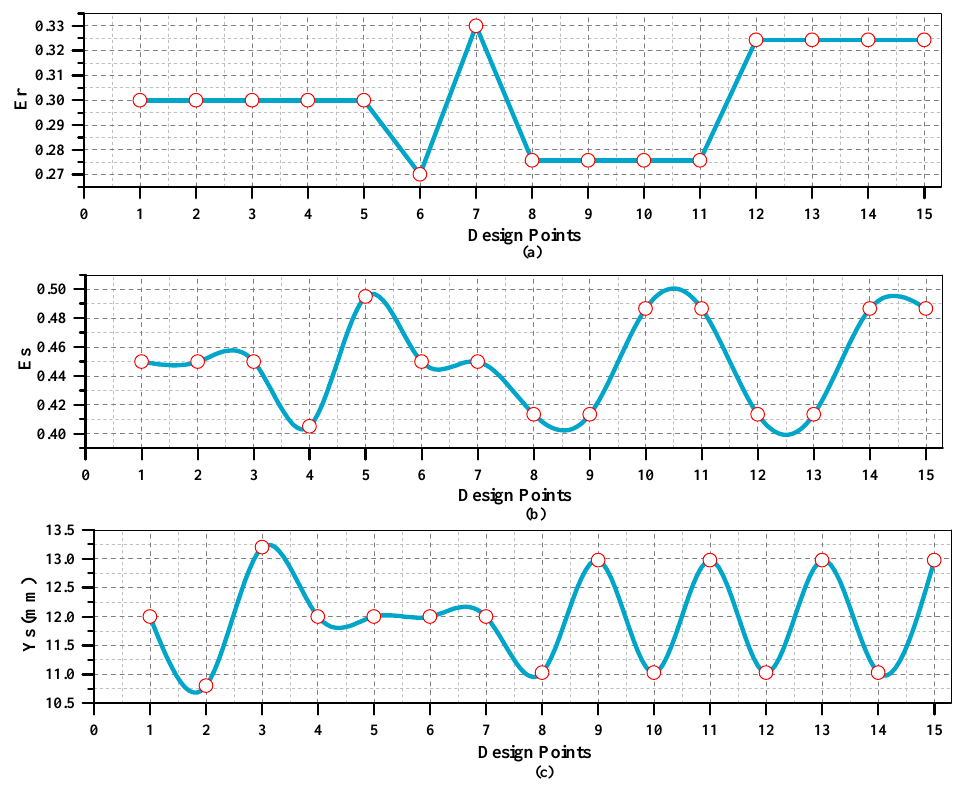
Figure 7. Input parameters with design points ( a ) E r with design points ( b ) E s with design points ( c ) Y s with design